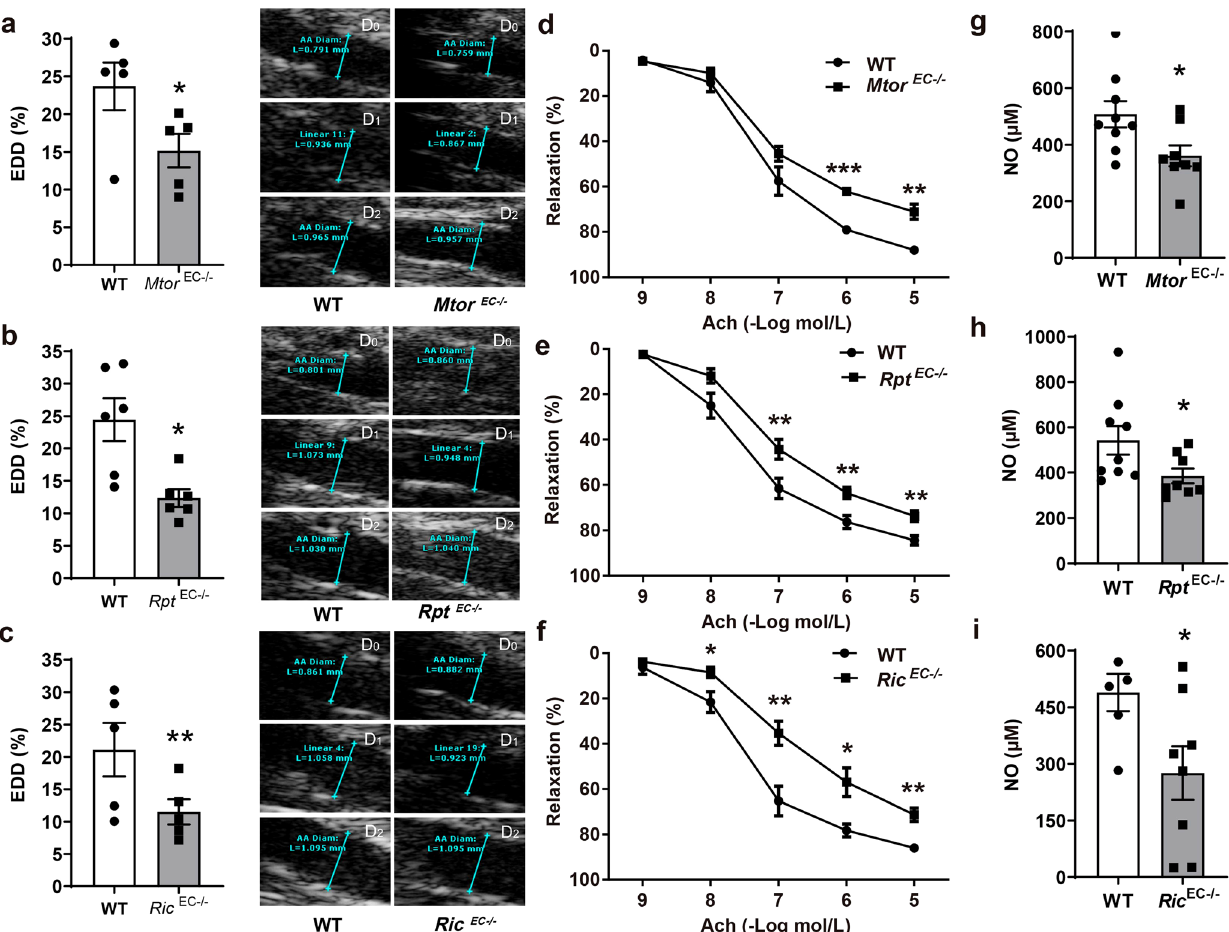
Fig. 1 EC-speci fi c deletion of Mtor, Rptor , or Rictor caused impaired relaxation of the artery accompanying decreased NO bioavailability. a – c Endothelium-dependent vasodilation (EDD) and endothelium-independent vasodilation (EID) of the abdominal aortas of Mtor EC − / − , Rptor (Rpt) EC − / − , Rictor (Ric) EC − / − mice and their wild type (WT) littermates were measured by transcutaneous ultrasound imaging ( n = 5 – 6) and calculated as follows: EDD% = ( D 1 – D 0 )/ D 0 × 100; EID% = ( D 2 – D 0 )/ D 0 × 100. Where D 0 is the mean diameter of the murine abdominal aorta over three cardiac cycles at baseline, D 1 is the maximum systolic diameter after fl ow-mediated dilation, and D 2 is the maximum systolic diameter after nitroglycerin infusion. Shown to the right are representative images of the abdominal aortas. Scale = 0.5 mm. d – f The dose responses of aortic rings to 10 − 9 – 10 − 5 mol/L acetylcholine (Ach) were evaluated by Myograph ( n = 5 – 8). g – i NO levels in the mouse serum was measured with a colorimetric reaction ( n = 7 – 9). Error bars correspond to standard error of the mean (SEM). * p < 0.05; ** p < 0.01; *** p < 0.001 vs. WT littermates; two-tailed unpaired t